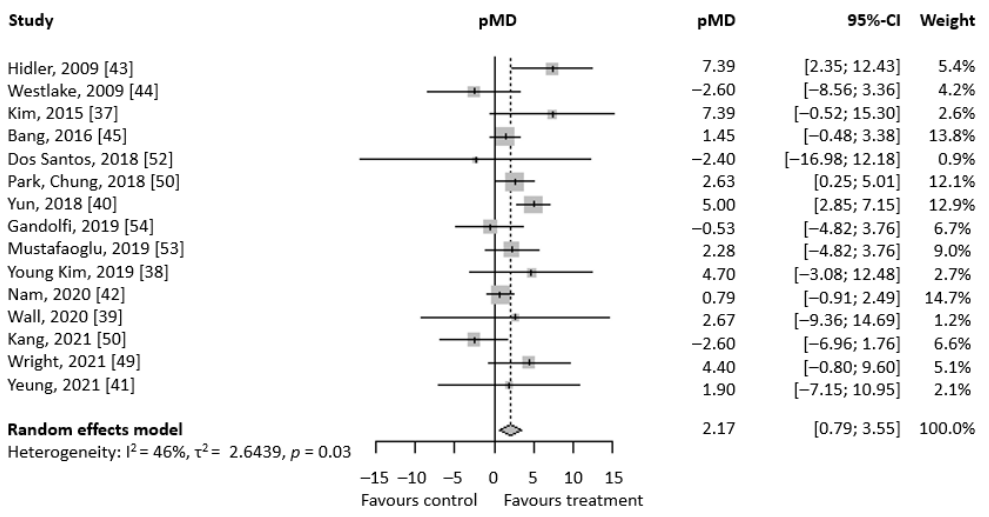
Figure 2. Forest plot regarding BBS meta-analysis. On the right, there are the mean pre-post differ- ence of each selected study and their respective 95% CI. At the bottom, there are total pMD, its 95% CI, and heterogeneity evaluation.